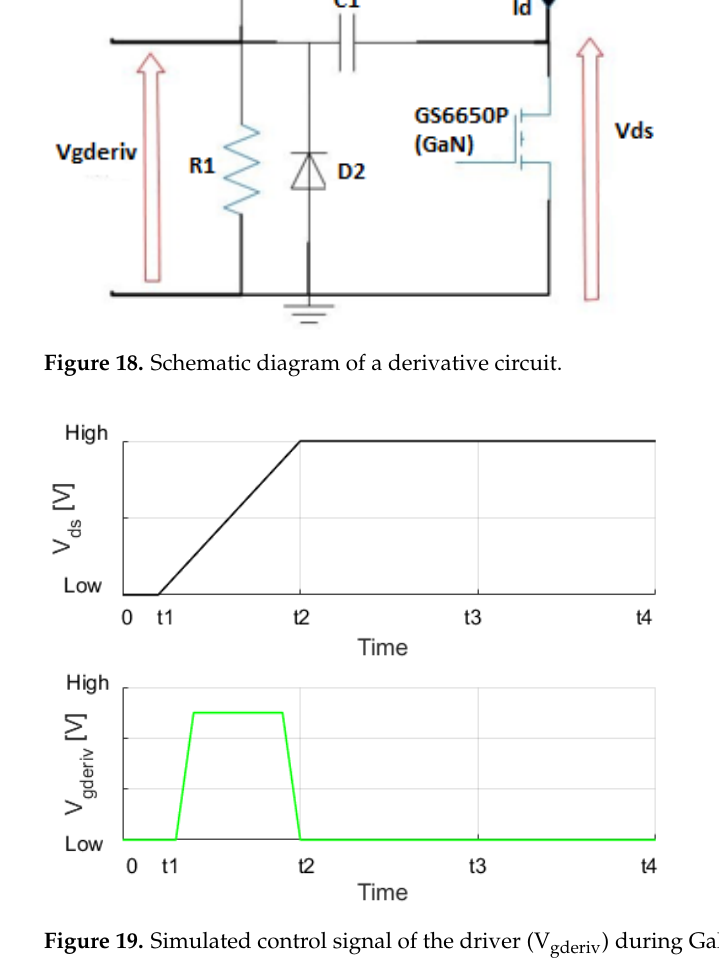
Figure 19. Simulated control signal of the driver (V gderiv ) during GaN transistor turn-off.